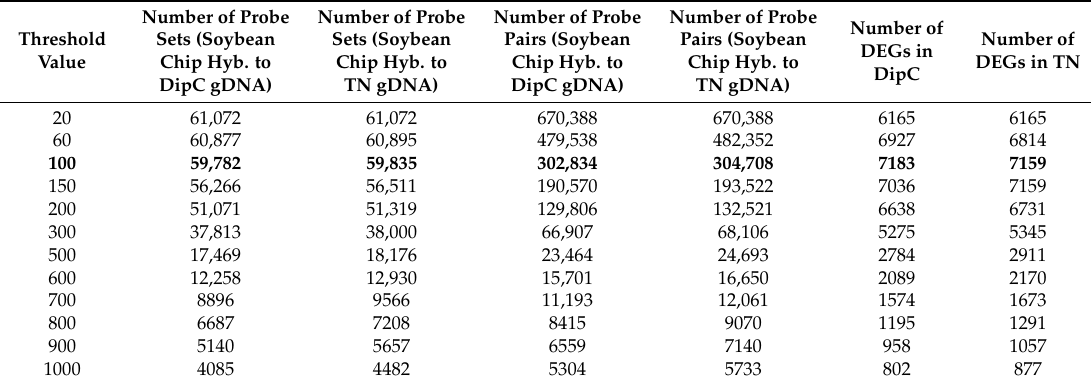
Table 1. Retained probe-sets and probe-pairs at different threshold values.